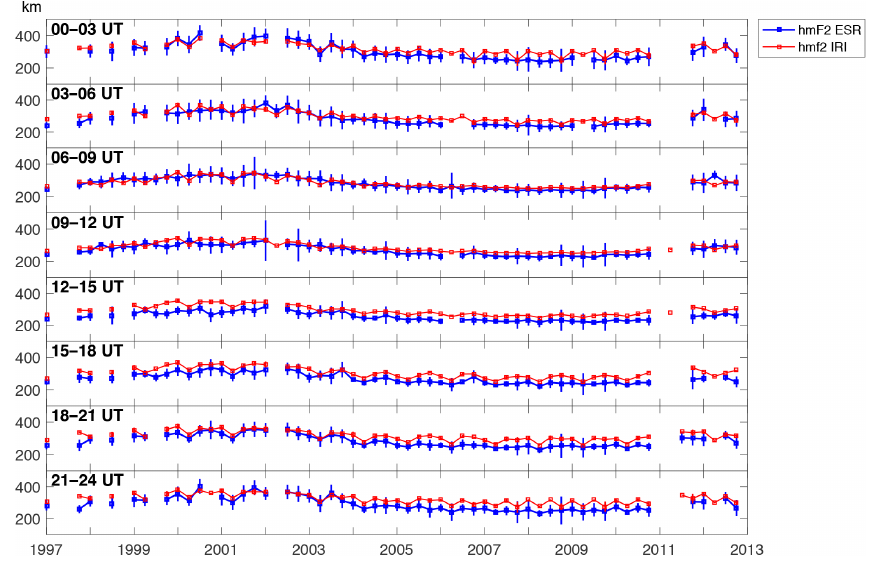
Figure 7. The height of the F2 peak from ESR (blue) and IRI model (red). Each panel corresponds to a 3h integration bin, and each year contains four seasonal bins (spring, summer, autumn and winter). Error bars correspond to 1 standard